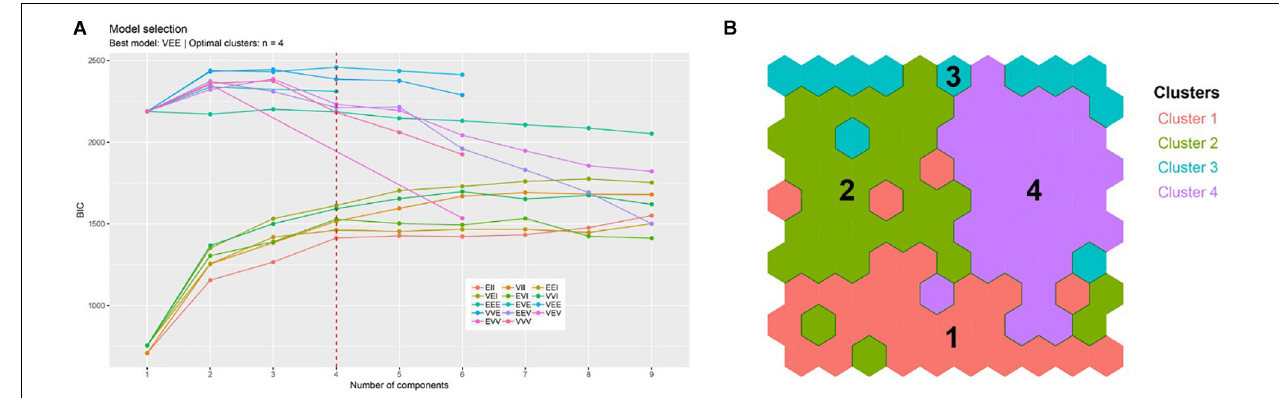
FIGURE 5 | (A) Outcome of the clustering algorithm and (B) the resulting partition transposed on the trained map.